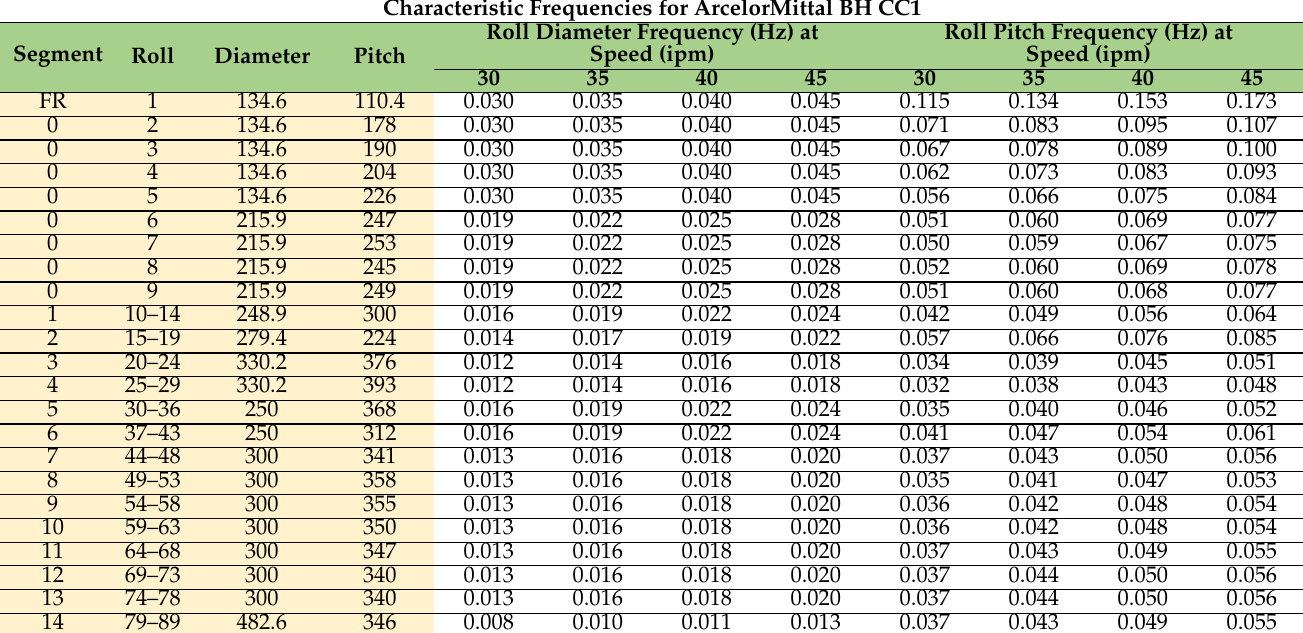
Table 1. Characteristic Disturbance Frequencies Calculated for Roll Eccentricity and Inter-Roll Bulging. Characteristic Frequencies for ArcelorMittal BH CC1